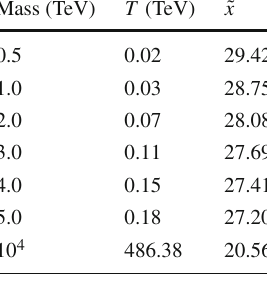
temperature ˜ T and ˜ x = m / ˜ T obtained from the condition in Eq. (21) for different values of the spin-half monopole mass